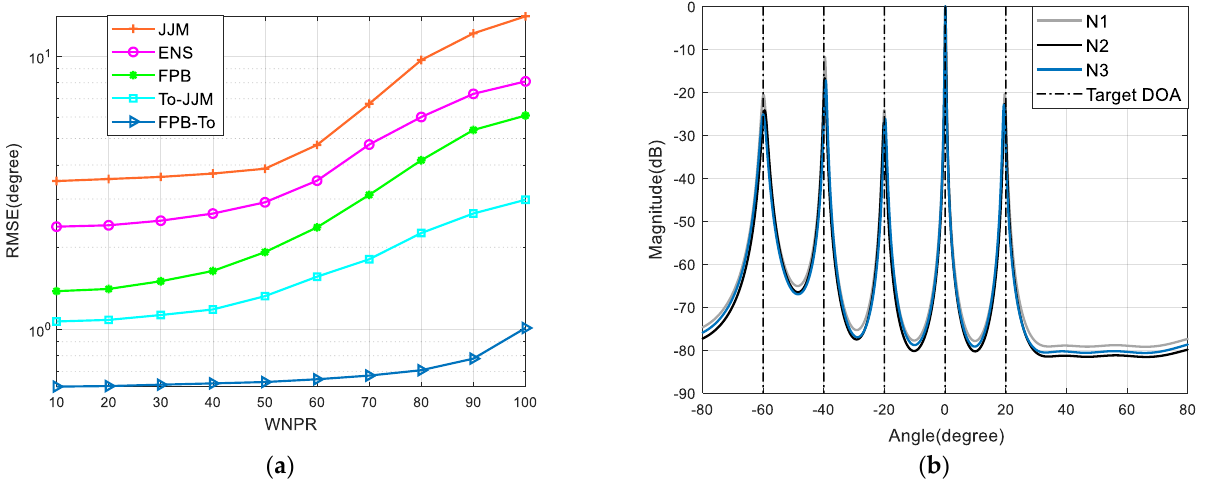
Figure 5. Algorithm robustness analysis: ( a ) Comparison of errors at different WNPRs; ( b ) Spatial spectral curves for different noise parameters.